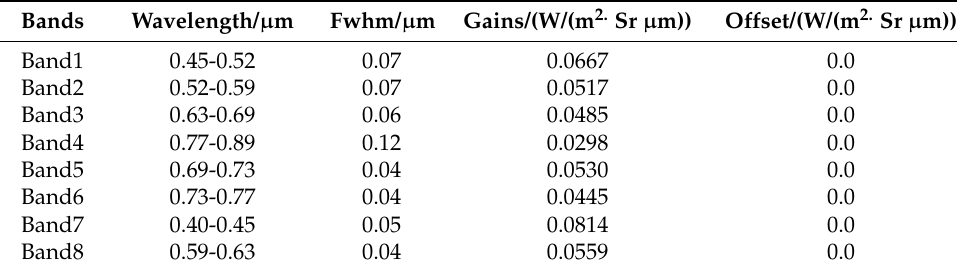
Table 1. GF-6 image data band